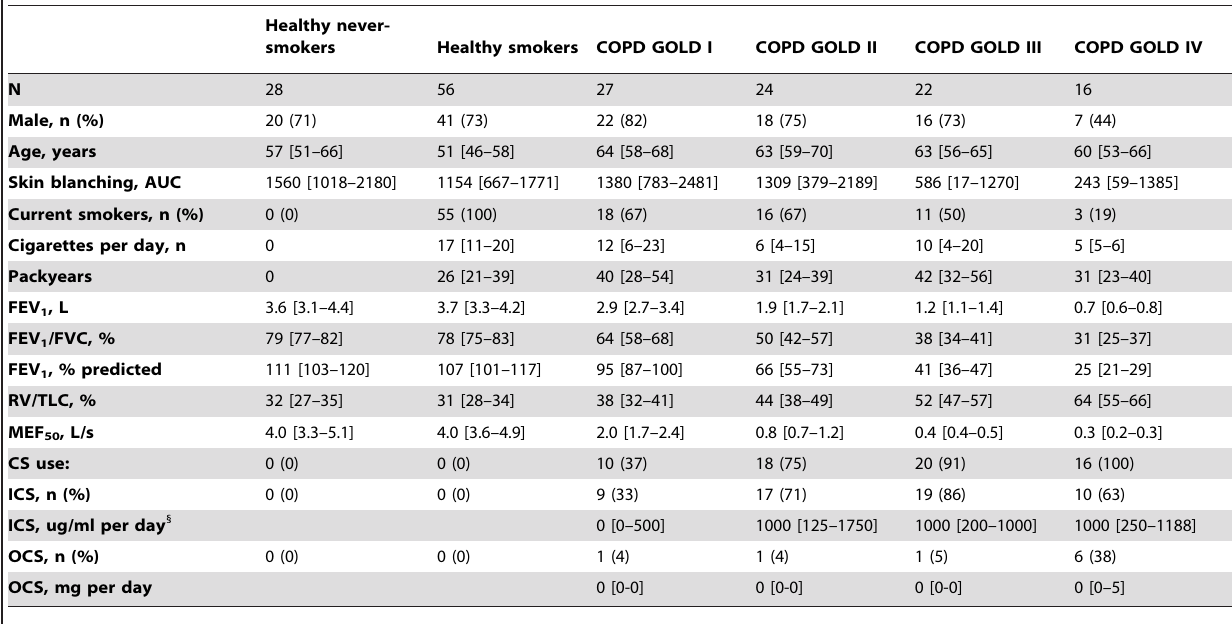
Table 1. Characteristics of the study population.